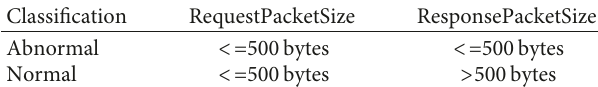
Table 3: List of selected artifacts for network monitor.